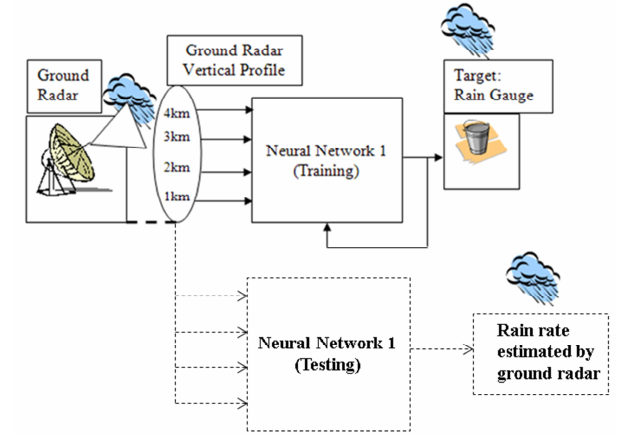
Fig. 5. Neural Network training. Input ground radar reflectivity. Tar- get: Rain gauge. Rain rate estimation (dashed line). Input ground estimation. radar reflectivity. Output: Rain rate